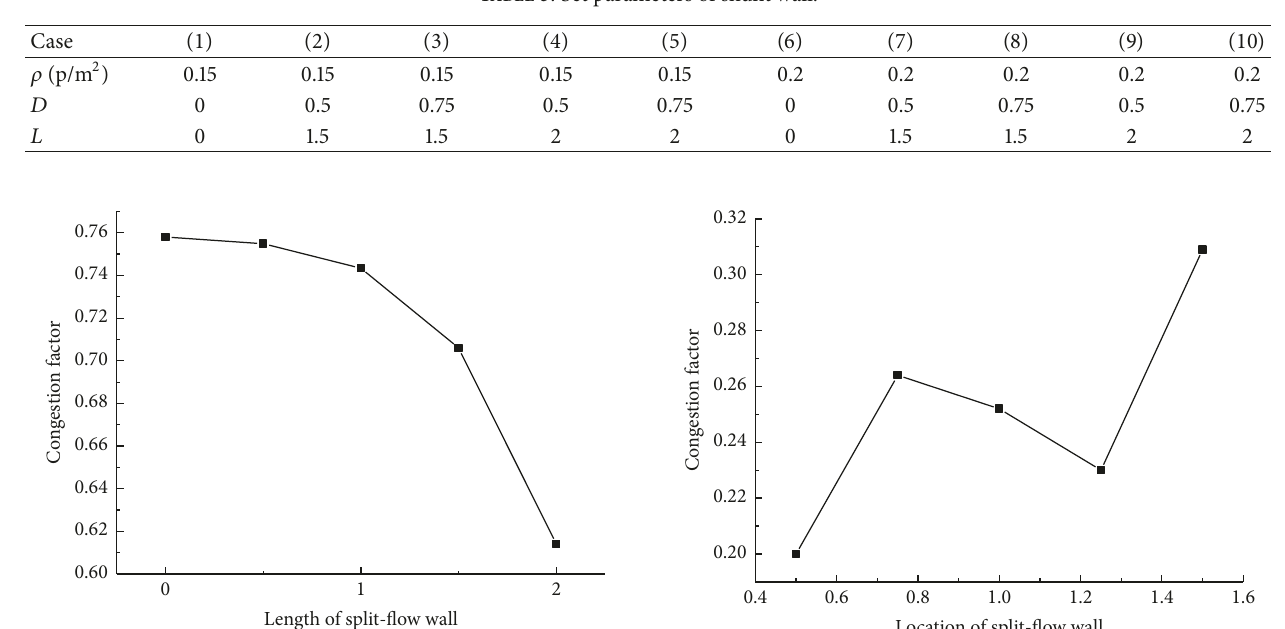
Table 3: Set parameters of shunt wall.